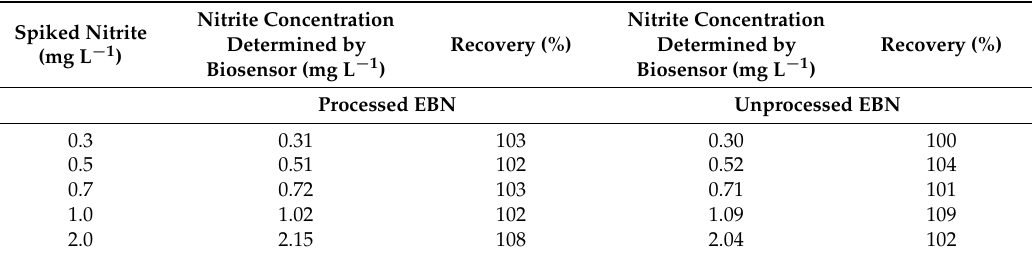
Table 2. The recovery of spiked nitrite in the processed and unprocessed edible bird’s nest (EBN) samples using the electrochemical nitrite biosensor ( n =